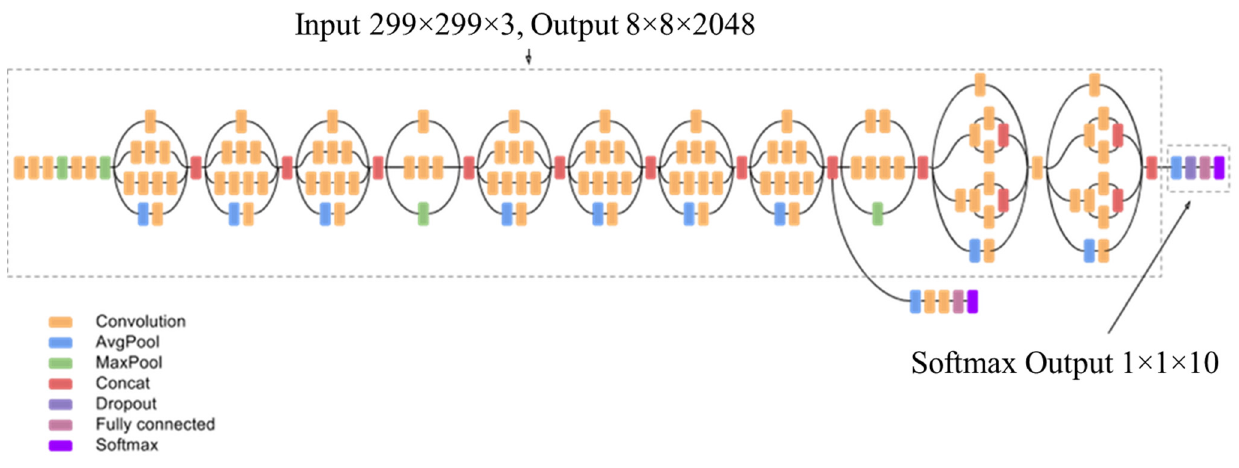
Figure 4. Inception V3 architecture modified from [34].